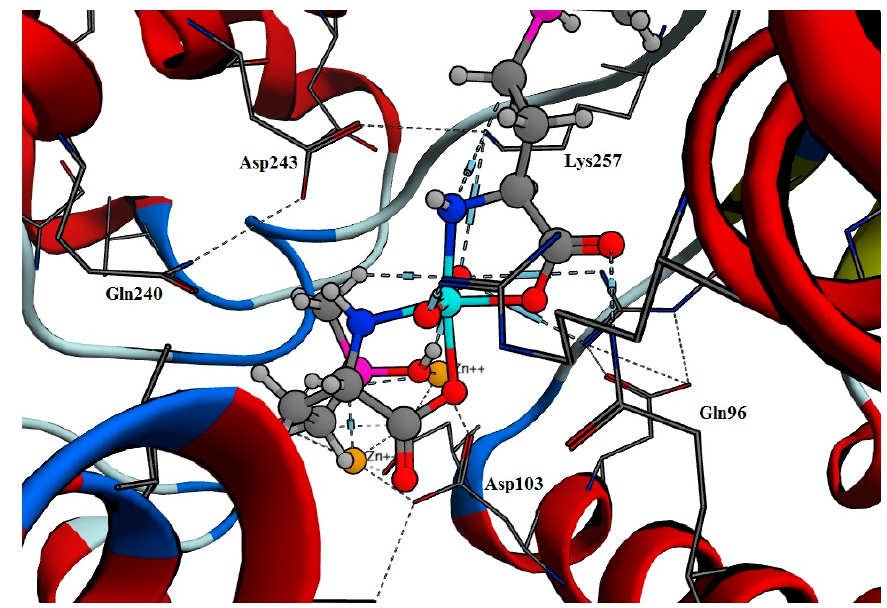
Figure 4. The orientation of Tc- phosphinothricin complex.